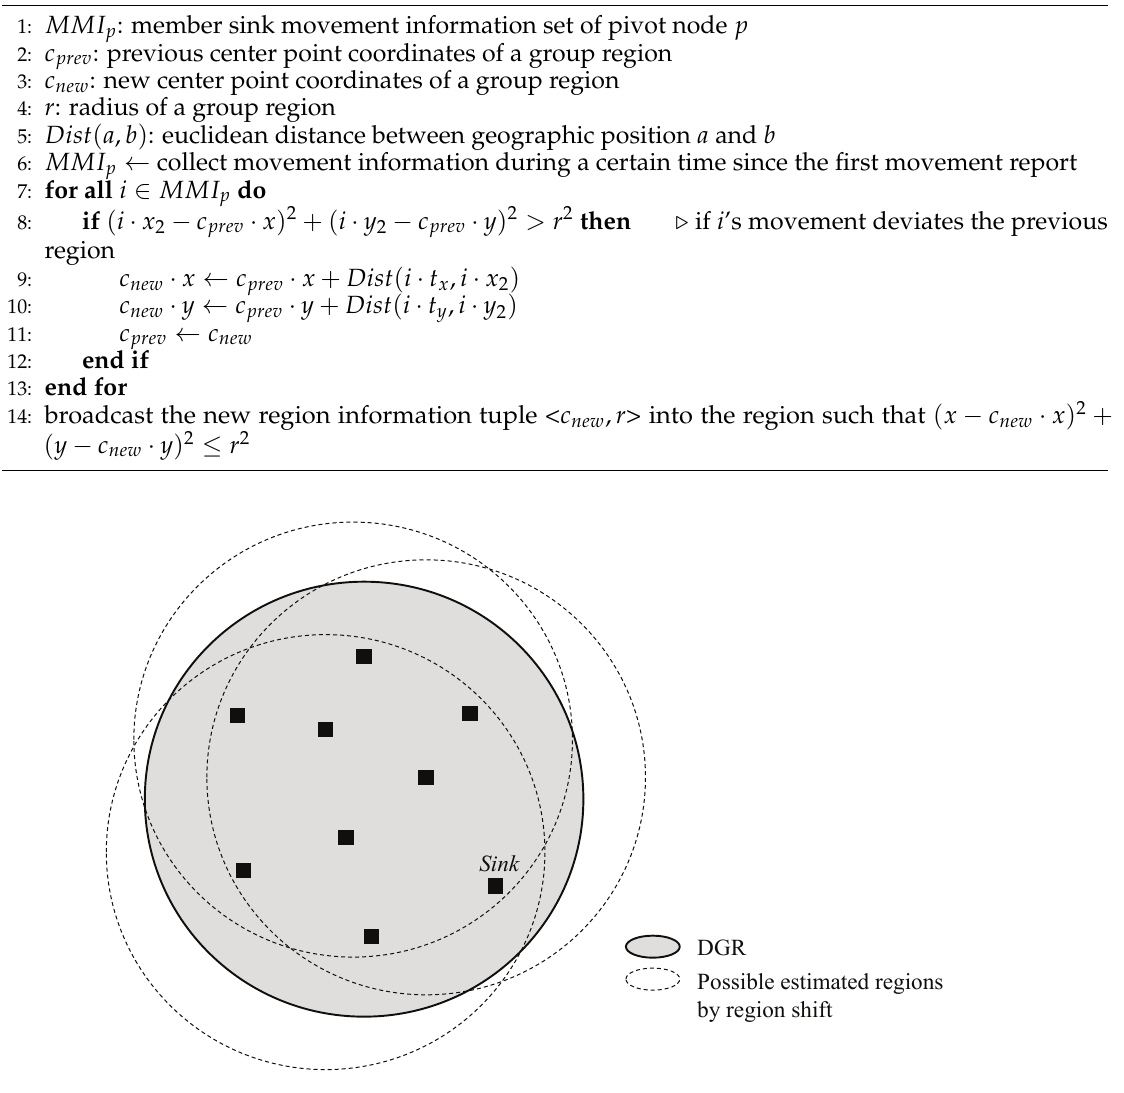
Figure 4. Relation between DGR and estimated